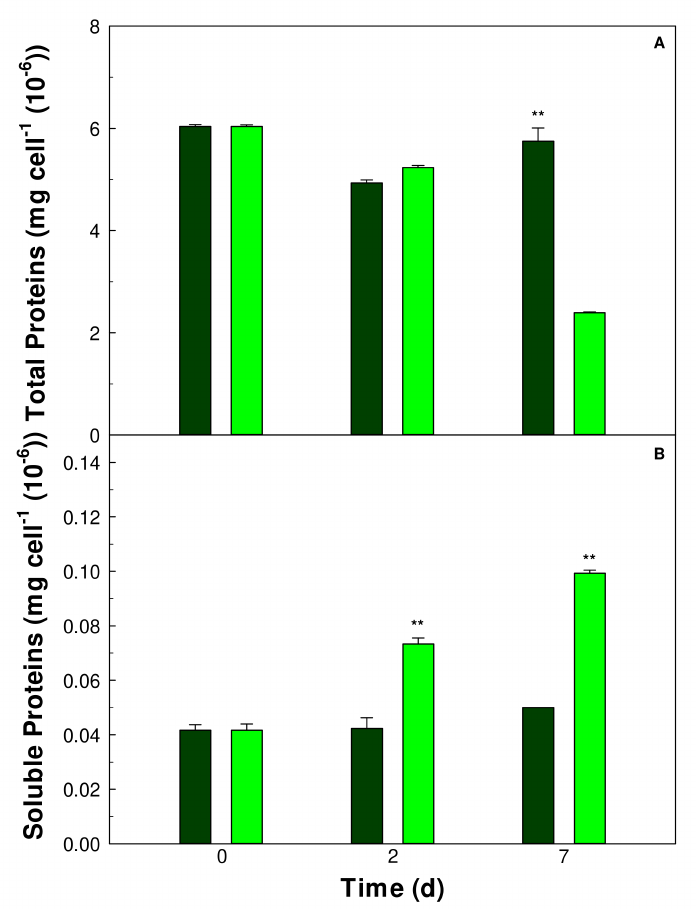
Figure 4. Total ( A ) and soluble ( B ) protein contents in Galdieria sulphuraria control (dark green) and S starved (-S, light green) cells. The proteins were measured at 0, 2 and 7 days from the start of the experiment. Error bars represent SD ( n = 3). Significant differences between control and -S were determined by Tukey HSD test and indicated by asterisks (** p <